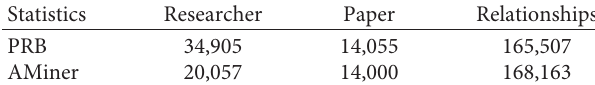
Table 2: Statistics of